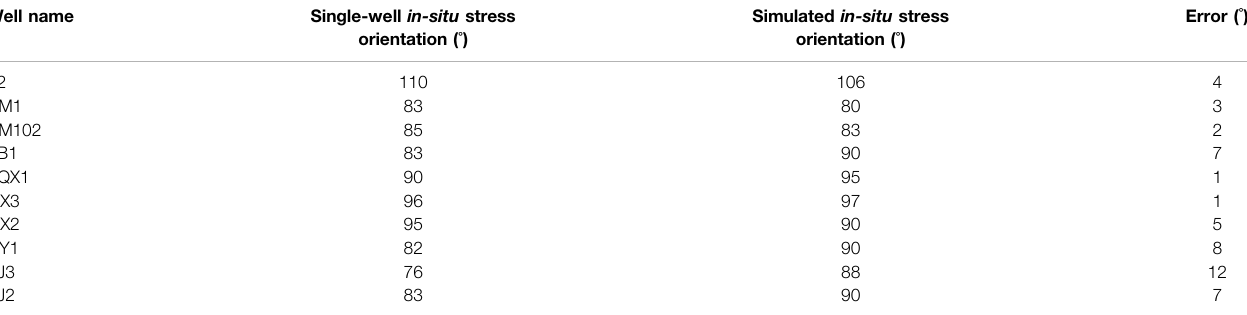
TABLE 1 | Comparative the simulation results and the orientations of principal stress by measurement. Well name